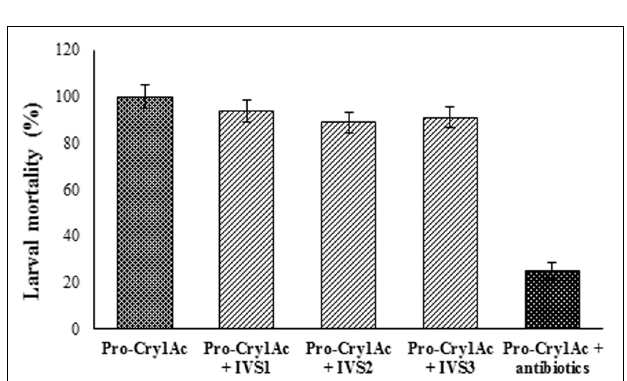
FIGURE 7 | Cry1Ac toxicity in antibiotic cocktail fed H. armigera larvae. Larvae were reared until the fourth-instar on sterile artificial diet amended with 100 µ l of antibiotic cocktail (Stock: 1 mg/ml of each antibiotic) per gram of diet. The antibiotic pre-treated early fourth-instar larvae were transferred to artificial diet treated with gut bacterial culture and pro-Cry1Ac (15 µ g/ml of diet) and reared for 5 days. Data was recorded for Cry1Ac toxin mortality in larvae reared on artificial diet, antibiotic cocktail treated diet and gut bacteria treated diet. Equal amount of culture from IVS1, IVS2, and IVS3 isolates was added to the artificial diet. There were three replications for each treatment and 10 larvae in each replication in a CRD. Each value represents the average of three